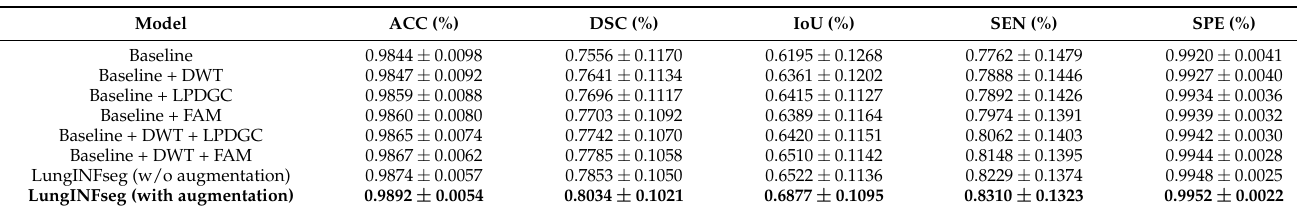
Table 3. Investigating the performance of different configurations of the proposed method (mean ± standard deviation). Best results are in